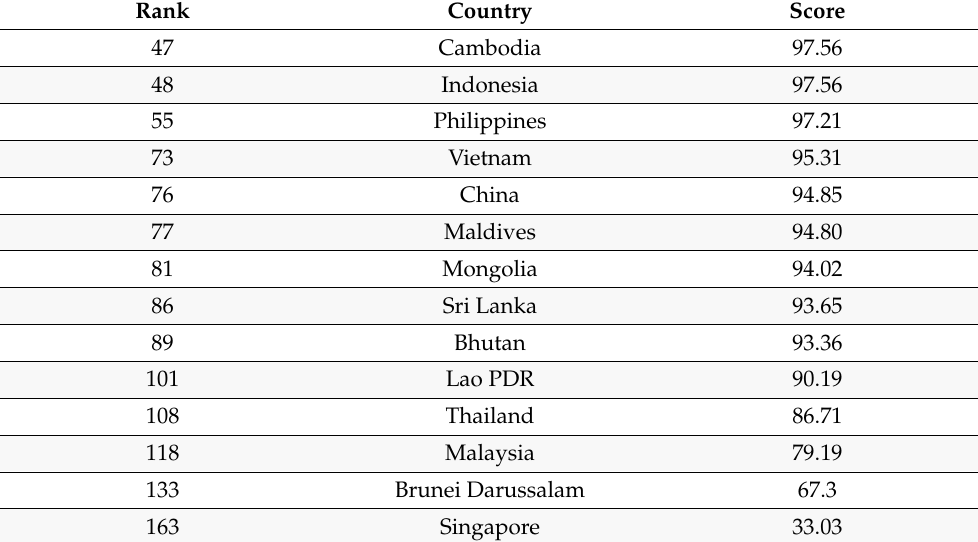
Table 2. Spillover Score for Reaching Sustainable Development Goals.